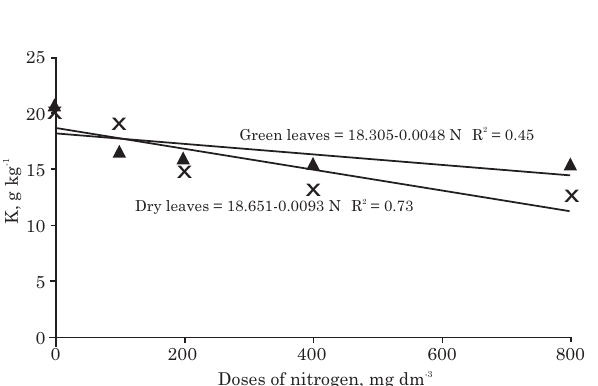
Figure 6. Influence of nitrogen fertilization on N concentration in green leaves and stems + sheaths of Brachiaria decumbens